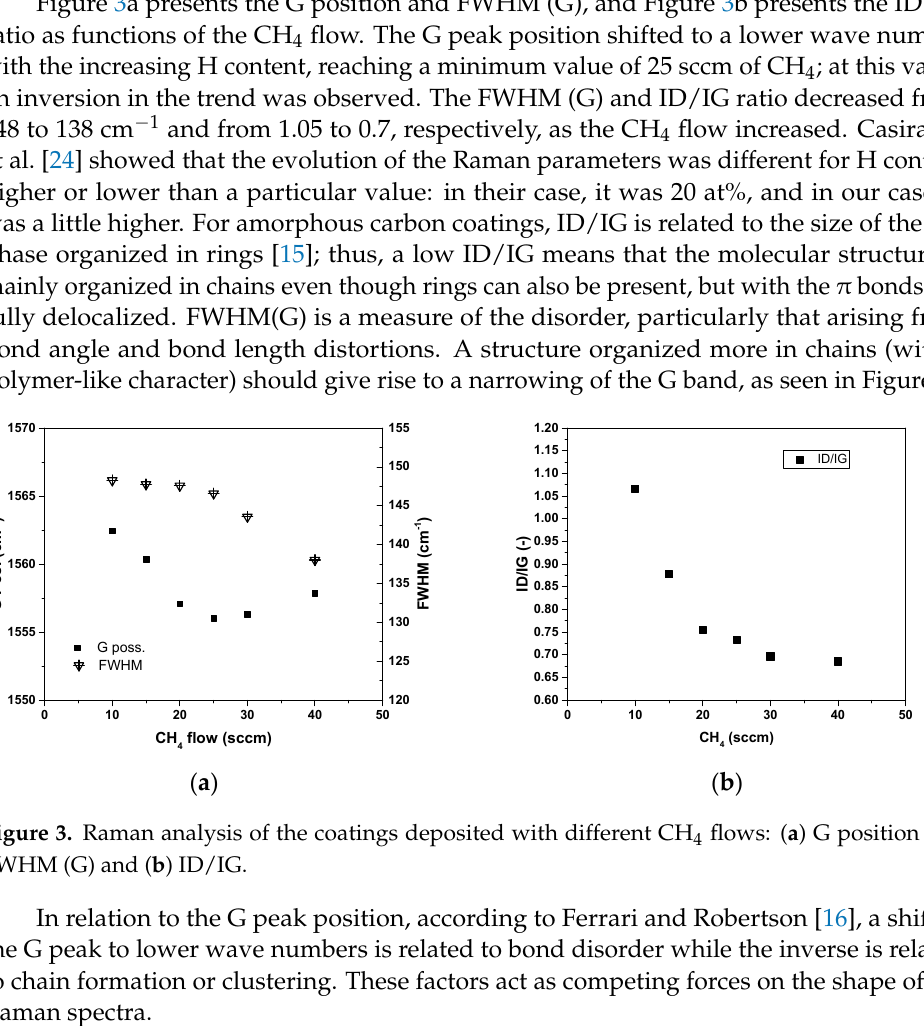
( b ) Figure 4. Optical micrographs of the scratch test: ( a ) coating deposited on steel substrates with 40 sccm of CH 4 , ( b ) coating deposited with 20 sccm of CH 4 . The mechanical properties of the coatings were evaluated with nanoindentation. The hardness and Young’s modulus had similar behavior with the increase in theCH 4 flow, as both showed a decreasing trend, as shown in Figure 5. Although there was a decrease in the W content from 5 to 2.9 at% (Table 1), this behavior was mainly related to the incorporation of H in the coating due to the changes that it caused to the bonding network and structure. With the increasing H content, the mechanical properties of the coatings tended to be determined by the polymer-like structure due to more C-H sp 3 hybridized bonds.